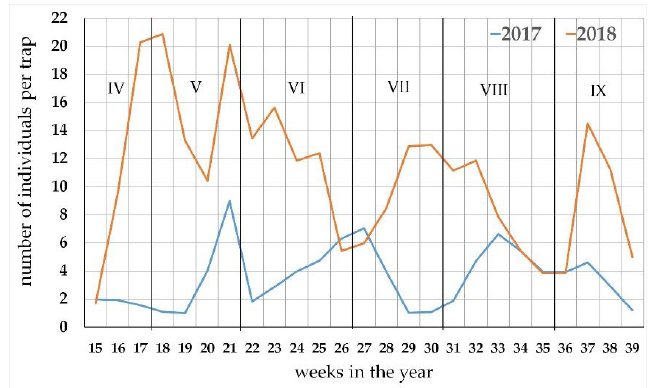
Figure 2. The seasonal activity of Carabus species in the oak hornbeam forest at the locality of Báb (southwestern Slovakia) during 2017 and 2018.